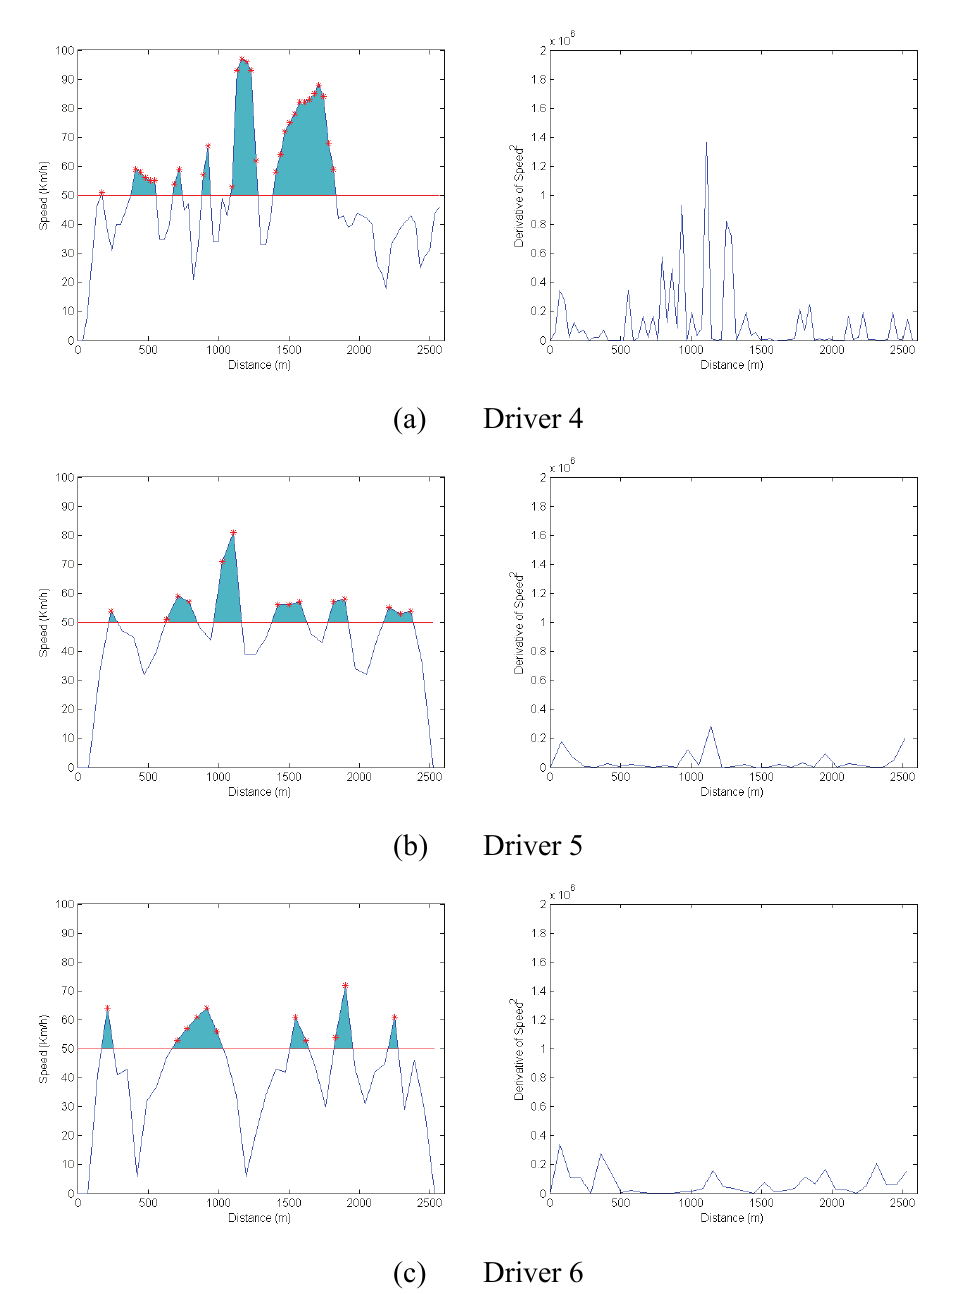
Figure 9. Results of aggressive